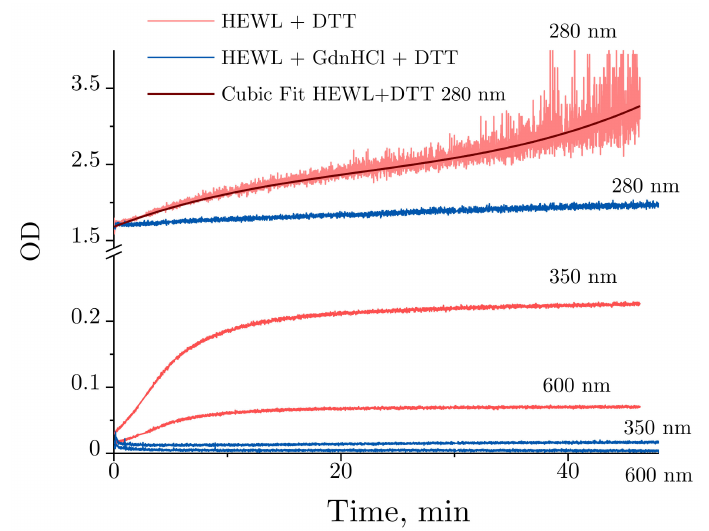
Figure 6. Time-dependent OD (optical density) changes obtained for 0.4 mg/mL HEWL denatured in 50 mM Tris-HCl (pH = 8.0) with 30 mM DTT (red) or 6 M GdnHCl and 30 mM DTT (blue) at 280, 350, and 600 nm. The OD changes of lysozyme treated with DTT at 280 nm against time were fitted with a cubic